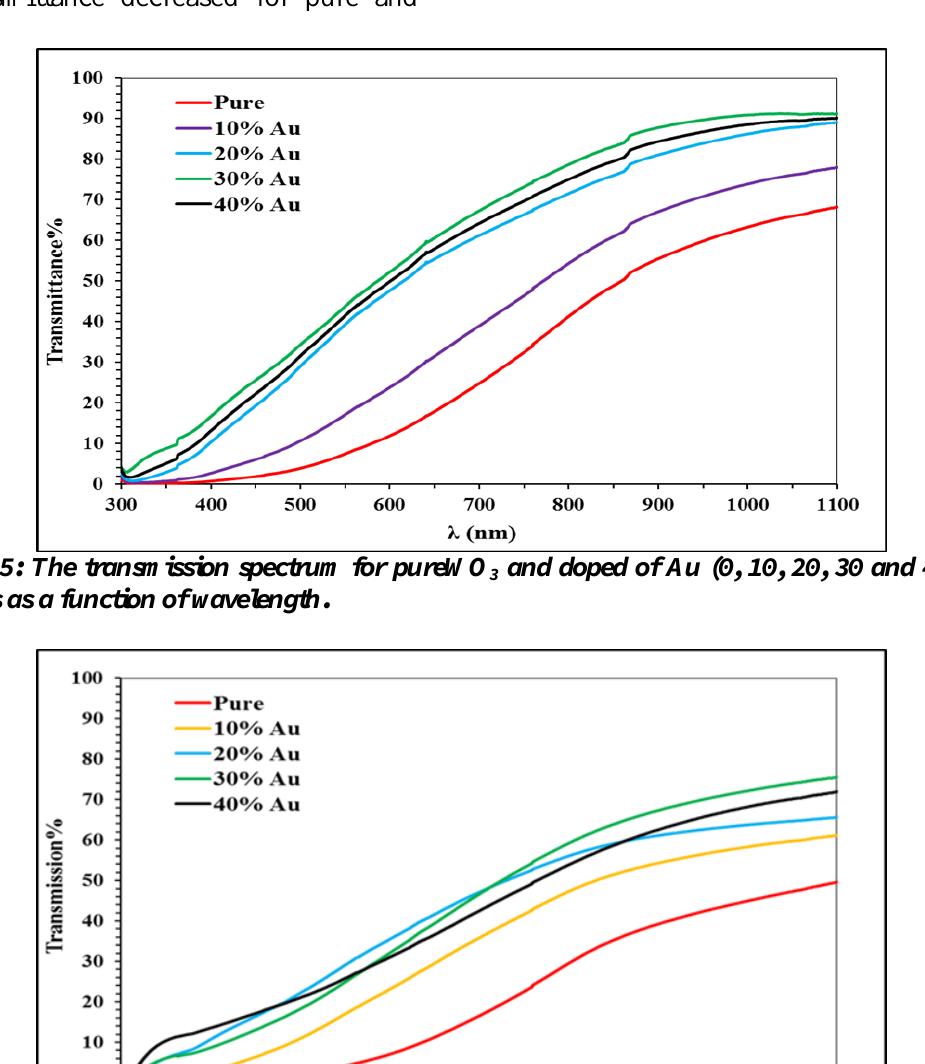
Fig. 6: The transmission spectrum for pureWO films as a function of wavelength at T